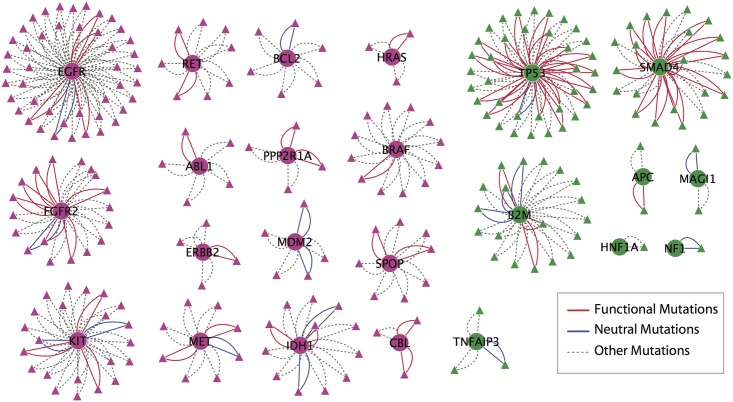
Bipartite protein-residue interaction networks of 34 cancer genes known to form homo-oligomers displaying only those residues involved in oligomerization.Edges are colored according to functional predictions made using VEST. Red lines indicate that mutations affecting that residue were predicted to be functional (VEST > 0.75), blue lines indicate a neutral prediction (VEST < 0.25), and dashed grey lines indicate mutations could not confidently be assigned a functional or neutral label.